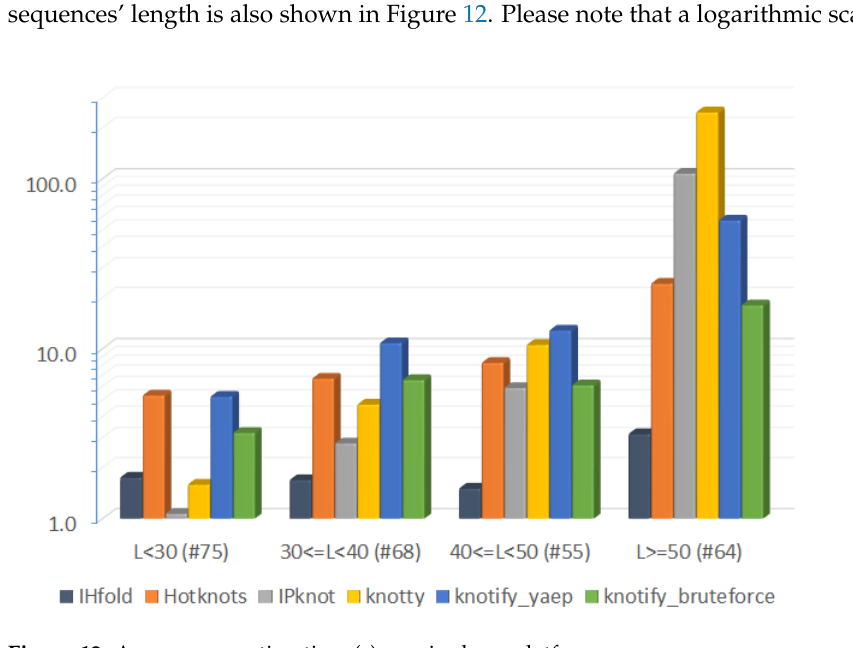
Figure 12. Average execution time (s) required per